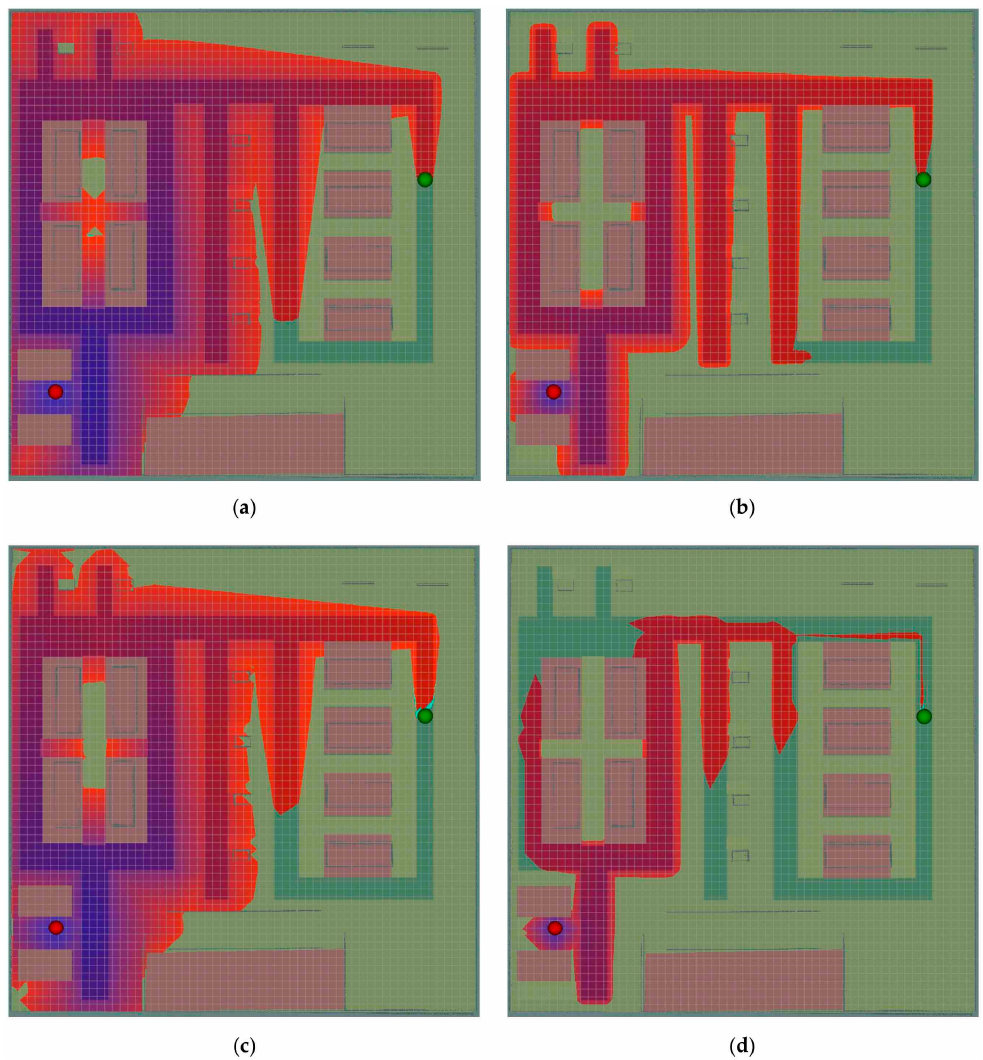
Figure 12. Path potentials of a path related to a start-goal-position tuple t ∈ T SC . Start position in red and goal position in green. ( a ) Dijkstra; ( b ) Dijkstra Zone ; ( c ) A*; ( d ) A* Zone .